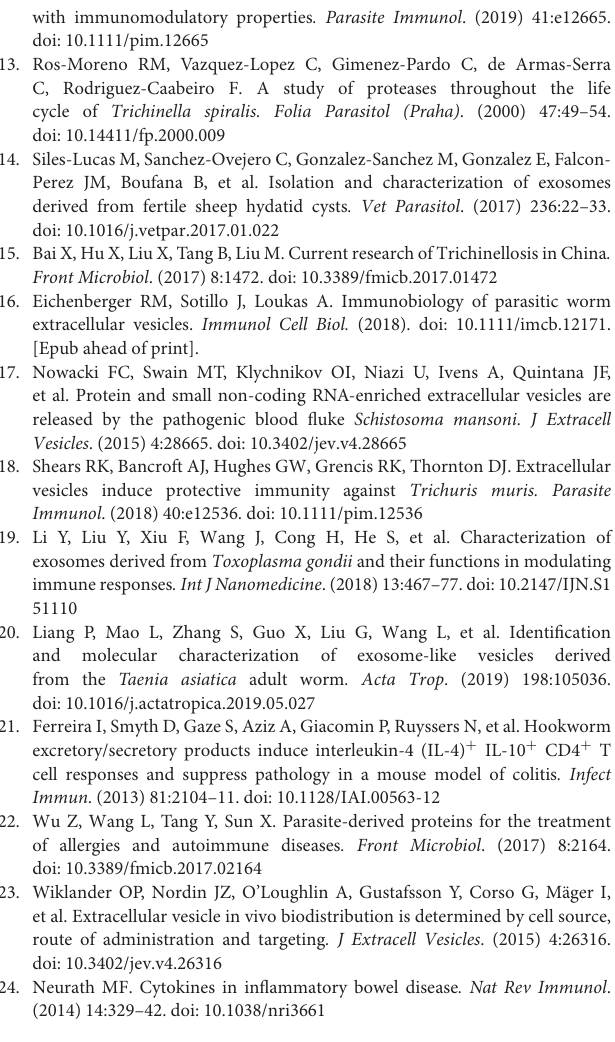
Table S1 | Prediction of Ts -EV miRNA interactions with murine host target genes. Heat map corresponds to individual target genes in the murine host based on